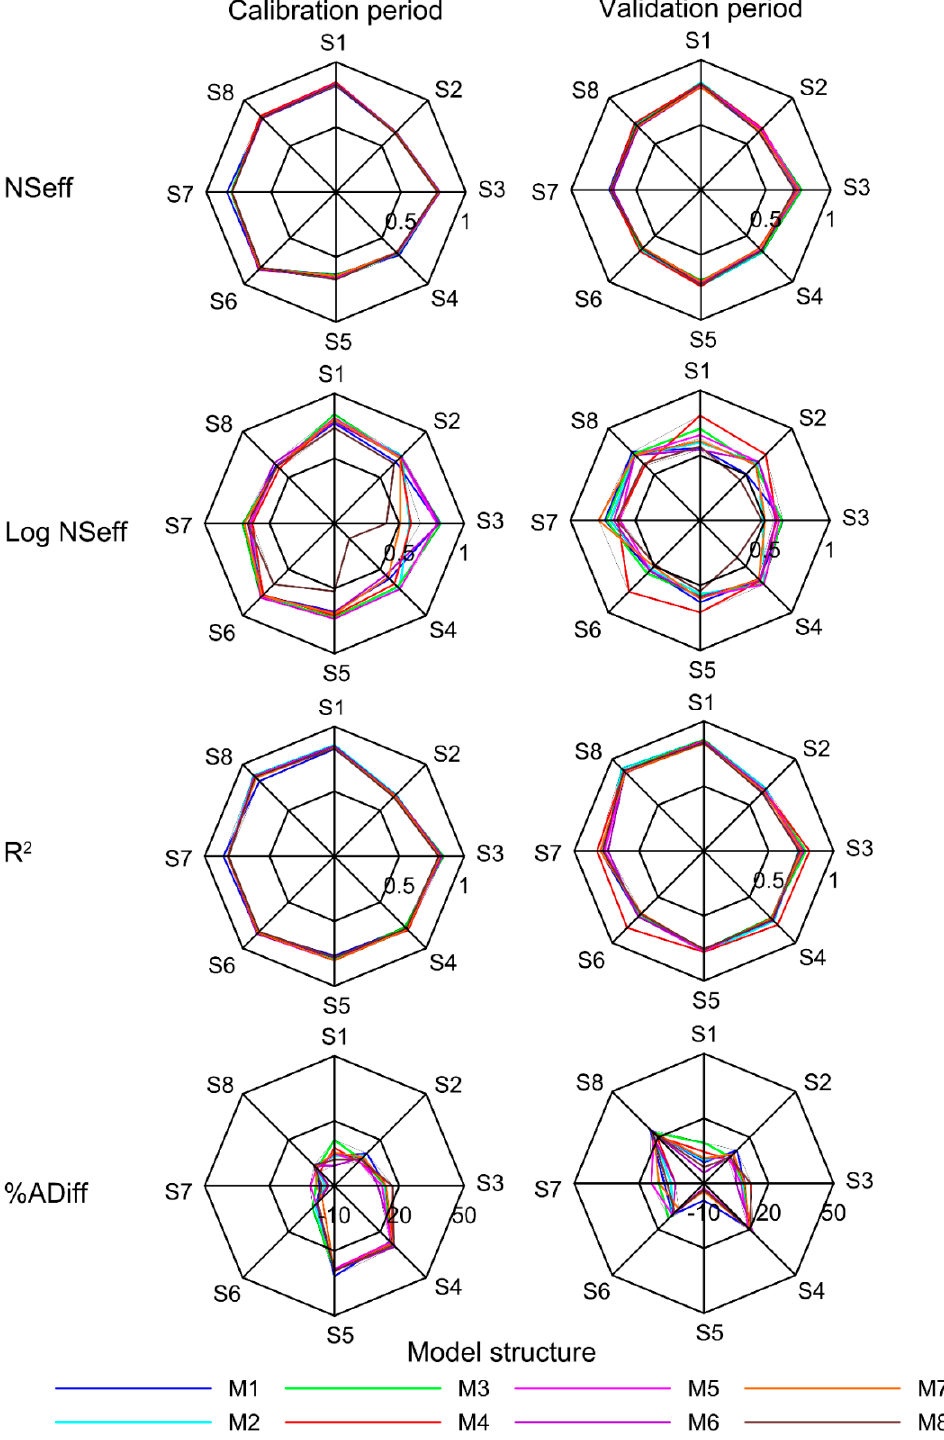
Figure 2. Performance indexes for the simulated runoff. Left column for calibration period and right column for validation period. Each axis represents a subcatchment (S1–S8) and each colored line represents a model structure